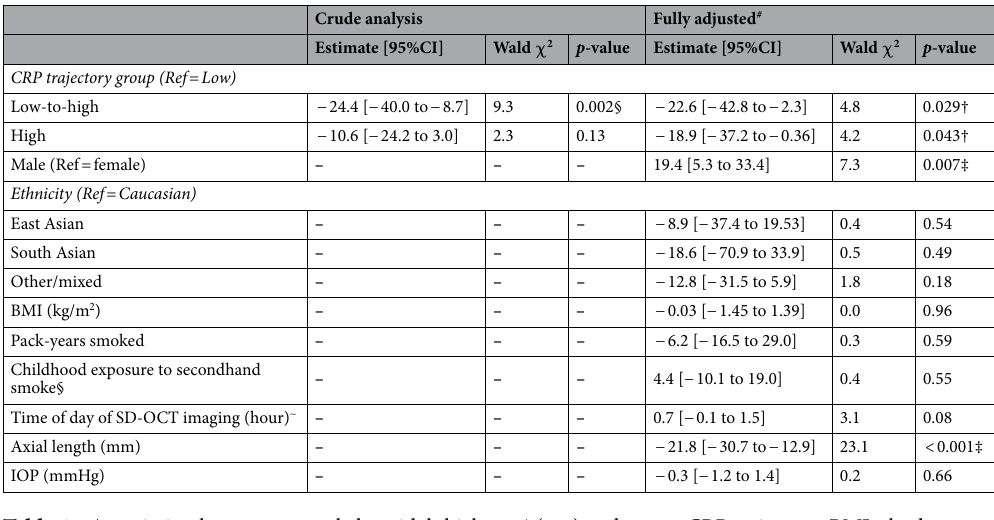
Table 4. Association between central choroidal thickness* (μm) and 7-year CRP trajectory. BMI = body mass index; CI = confidence interval; CRP = c-reactive protein; IOP = intraocular pressure; SD-OCT = spectral